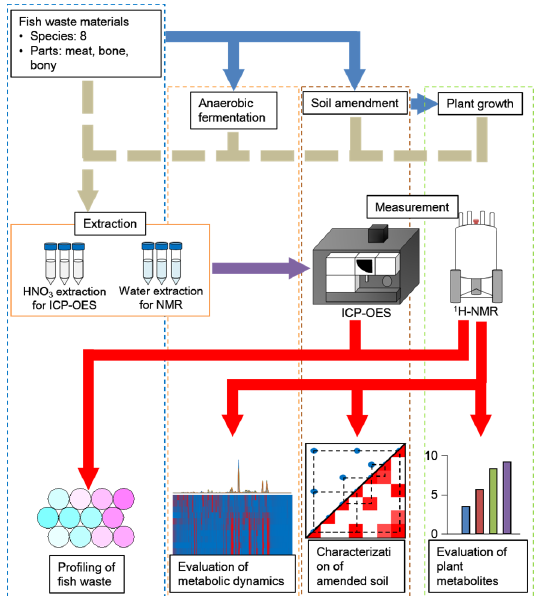
Figure 1. Schematic flow of this study. Sample preparation, those measurements and data visualization are shown from top to bottom, whereas four kinds of evaluation systems are aligned vertically, respectively.